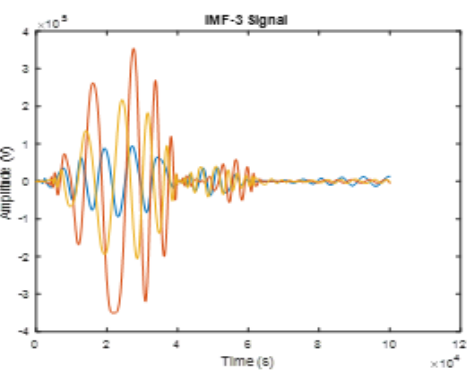
Figure 13. Simulated: wavelet Transform for three phase-ground fault signals